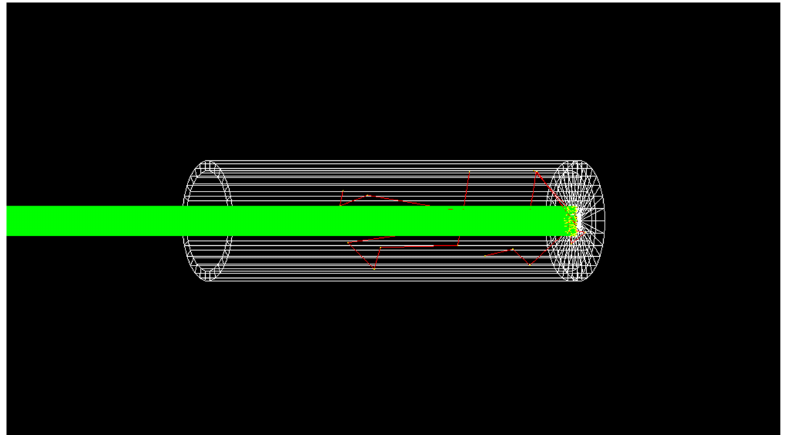
Figure 3. Model of the cavity absorber using Geant4. The absorber is a cylinder with a bottom (white wireframe). Incident photons are mainly absorbed by the cylindrical copper bottom. Scattered photons, fluorescence photons, and electrons produced by interactions between X-rays and copper are reabsorbed by the cylindrical copper shell. The green lines represent trajectories of the photons and the red lines represent trajectories of the